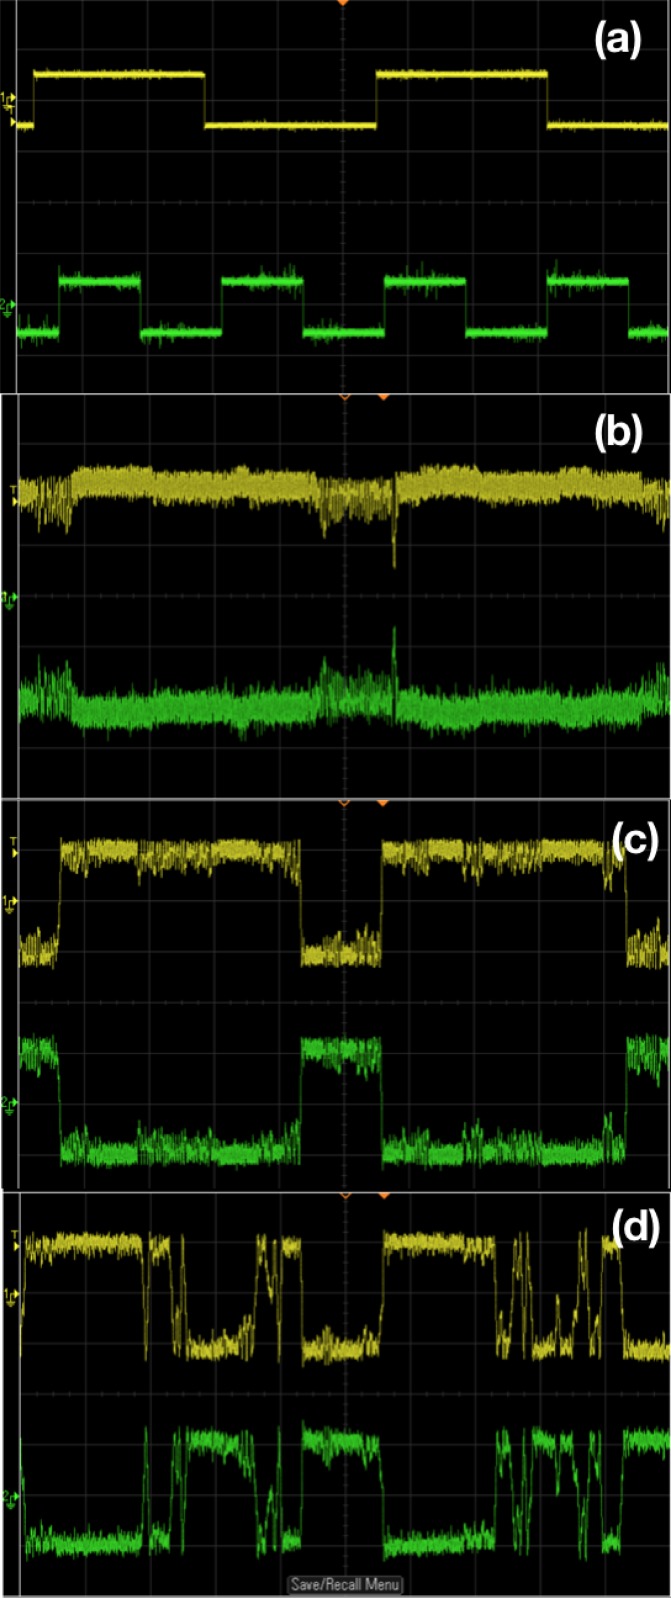
Realization of the OR/NOR logic gate at intermediate noise strengths in electronic circuit experiments.Panel (a) shows stream of inputs I1 and I2 (which take value −10 mV when logic input is 0 and value 10 mV when logic input is 1). Panels (b) to (d) show the output voltage V(t) (yellow) and VL(t) (green) for different noise strengths D: (i) 100 mV, (ii) 1.0 V and (iii) 1.5 V. Clearly panel (c) depicts logical OR output (with V(t) > 0 being logic output 1, and V(t) < 0 being logic output 0). The output voltage VL(t) (green) yields the complementary NOR logic gate response. The amplitude A of the sinusoidal signal is 100 mV and frequency is 8890 Hz. The bias voltage b, is fixed as 10 mV. For panel (a), the scale in the traces are: 20 mV/Div (Y-axis) and 5 mS/Div (X-axis). For panel (b-d), the scale in the traces are: 100 mV/Div (Y-axis) and 5 mS/Div (X-axis).